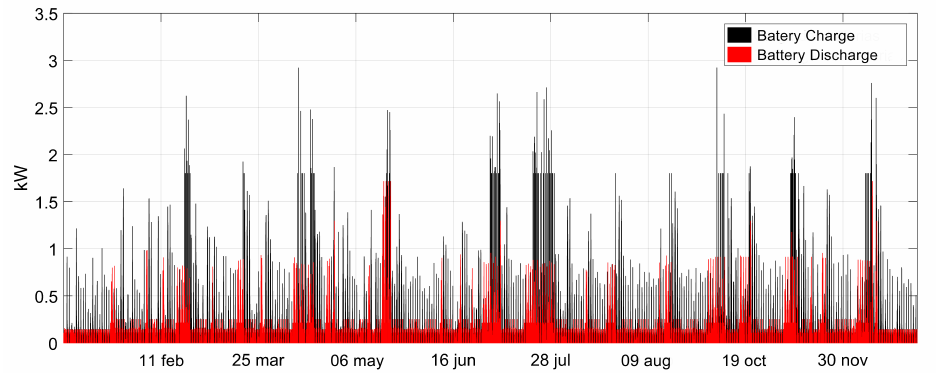
Figure 15. Battery bank charging and